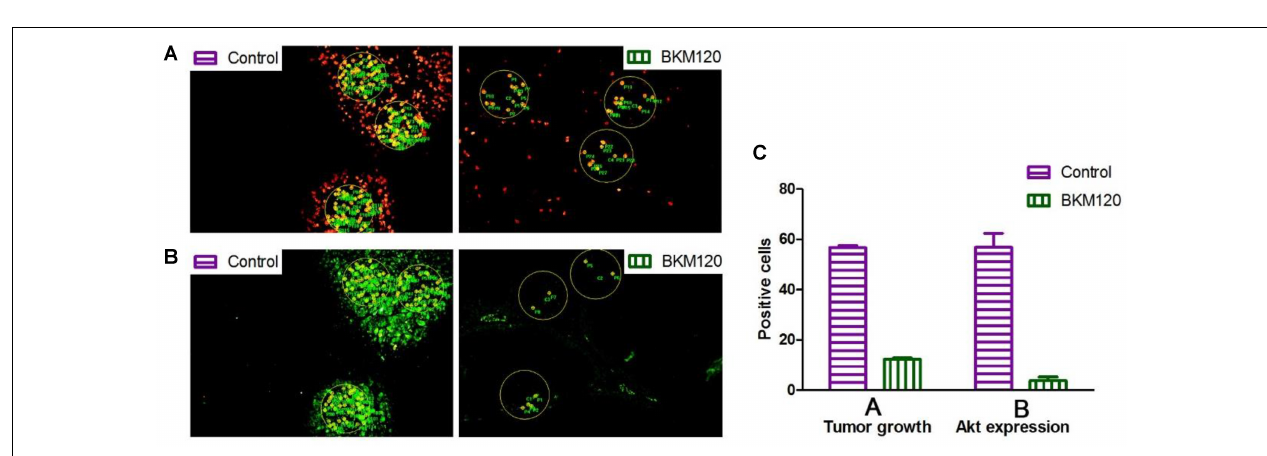
FIGURE 4 | Evaluation of in vivo target efficacy of BKM120 and PX-478. The green fluorescence show the expression of the target proteins Akt and HIF 1 α . The red fluorescence show the EdU labeling. (A) Mice with MCF-7 xenograft tumor were treated with BKM120, phosphorylated Akt was examined. (B) Mice with H460 xenograft tumor were treated with PX-478, HIF 1 α was detected. Scale bar indicates 2 mm.